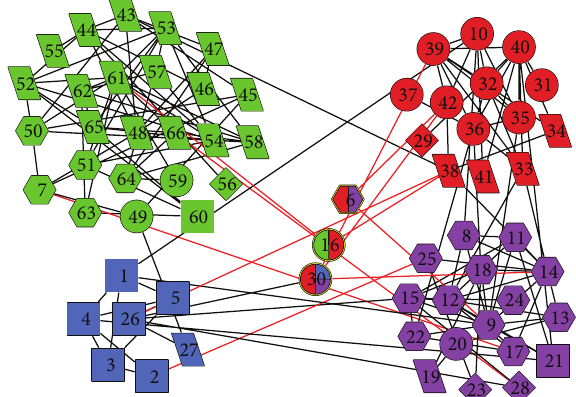
Figure 7: Detection result obtained by MRLD in real-world mobile